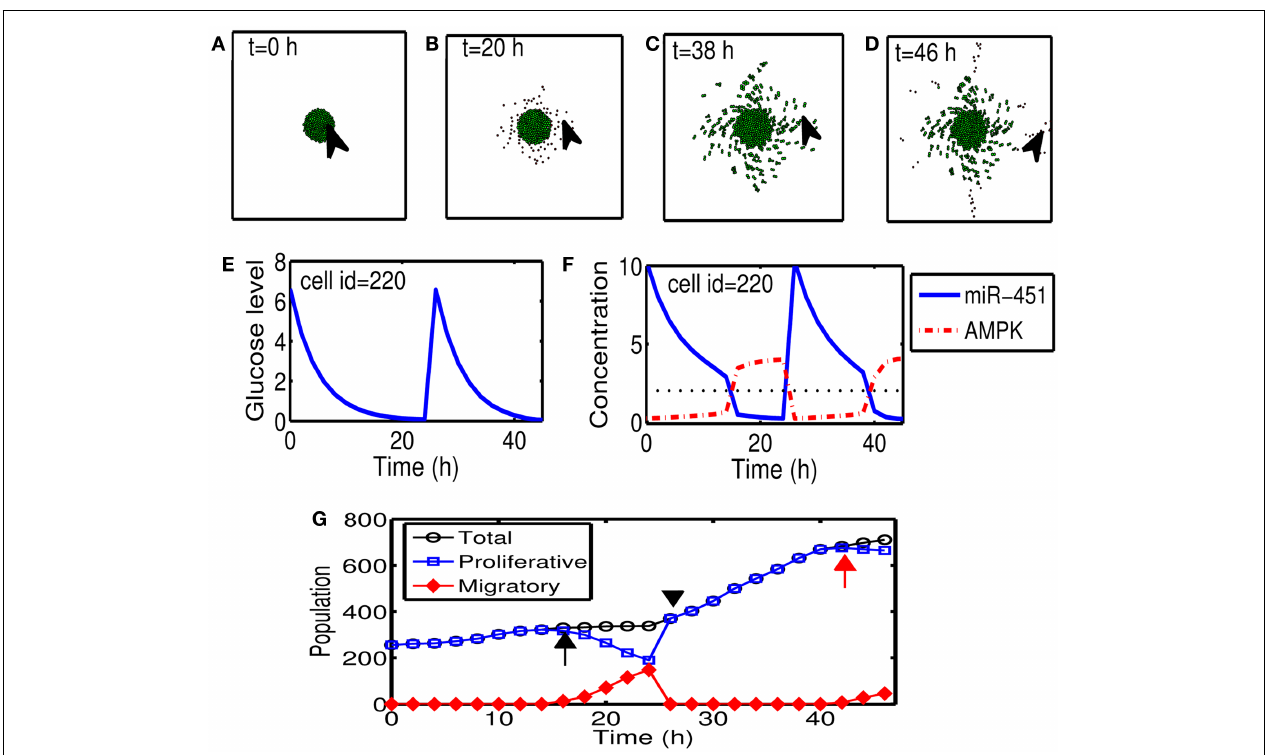
middle = threshold value of miR-451 ( th M ). (G) Time course of cell populations: proliferative (blue square), migratory (red diamond), and total (black circle) cells. Some of proliferative cells become migratory ones around t = 16h (black arrow) and t = 42h (red arrow) when miR-451 levels drop below threshold due to lowered glucose levels. All migratory cells enter the proliferative phase around t = 26 (black arrowhead) in response to glucose injection.